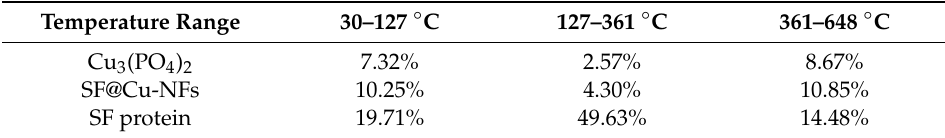
Figure 6. TGA spectrum of (i) Copper phosphate; (ii) SF@Cu ‐ NFs nanoflower; (iii) SF protein. Table 1. Thermogravimetric data of TGA spectrum (i) copper phosphate; (ii) SF@Cu ‐ NFs nanoflower; (iii) SF